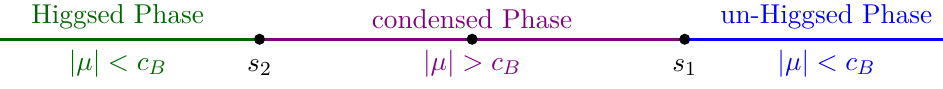
Figure 12 . Phase diagram of critical boson theory as a function of m cri (cid:0) 2 −| λ (cid:1) s 2 = −| µ | the system undergoes a sharp second order phase transition from a condensed B | | λ B | to an uncondensed phase. The black dot inside the condensed phase marks the point where the description of the physically unique condensed phase changes from one of a phase of condensed scalars to a phase of condensed W bosons; this occurs at m cri